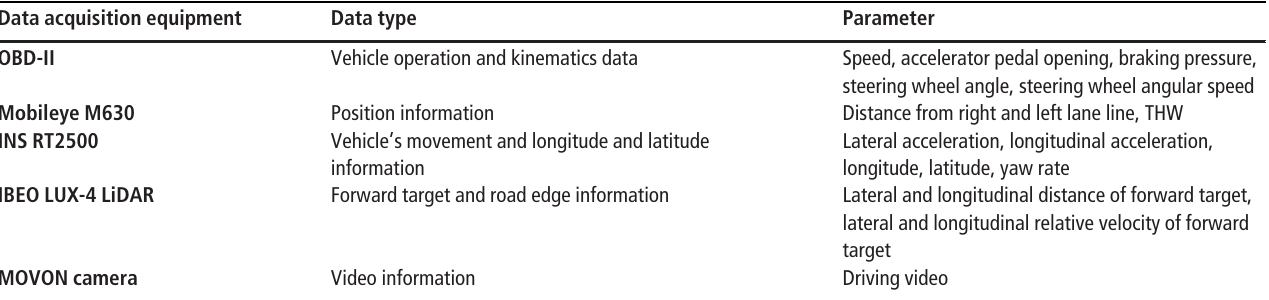
Table 1 Original data collected by naturalistic driving experimental platform